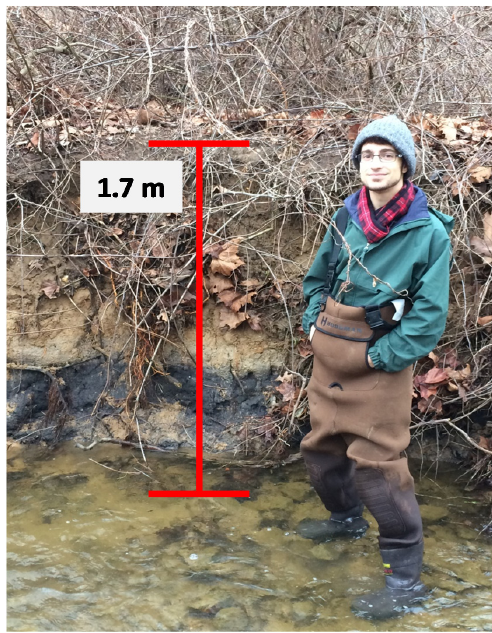
Figure 2. Light-colored legacy sediments overlying a dark, organic-rich precolonial horizon along Gramies Run. Fibrous organic material in the dark organic horizon was radiocarbon dated to a mean age of 950 ± 30 BP. The bank height (indicated by the red bar) was about 1.7 m, and the thickness of the organic horizon at this location was 30 cm or more. The organic horizon was visible for a length of 500 m along this reach of Gramies Run.